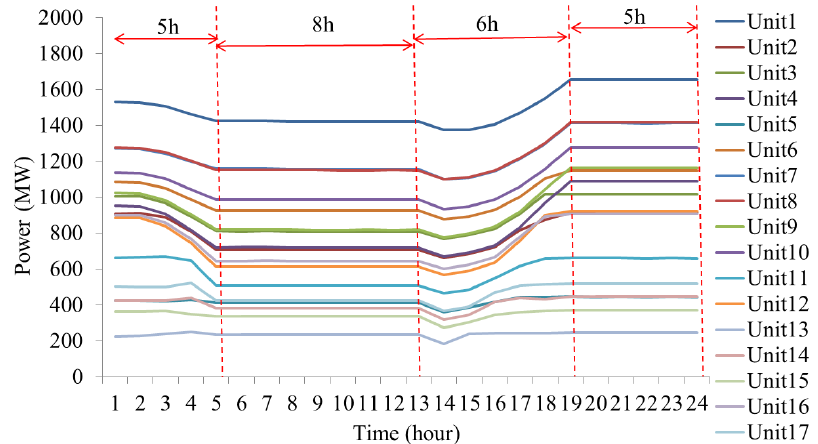
Figure 8. Thermal power outputs in Case 2.